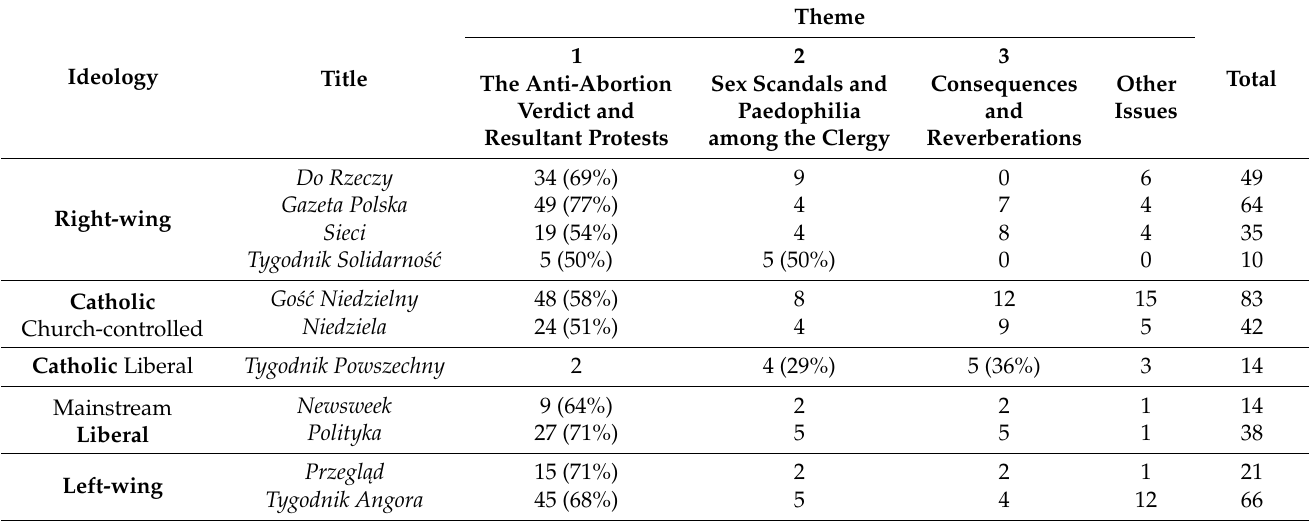
Table 3. The main themes associated with the crisis situation in the Catholic Church discussed on the pages of Polish opinion-forming weeklies between mid October and December 31,